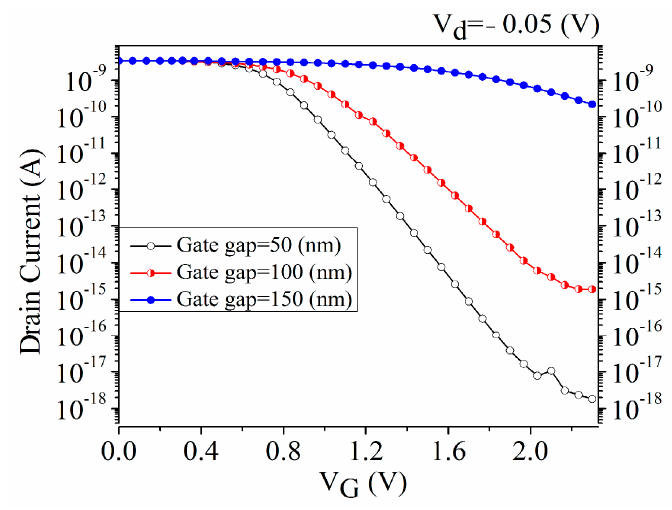
Figure 8 . Output characteristics comparison of three devices with 50, 100 and 150 nm gate gap.